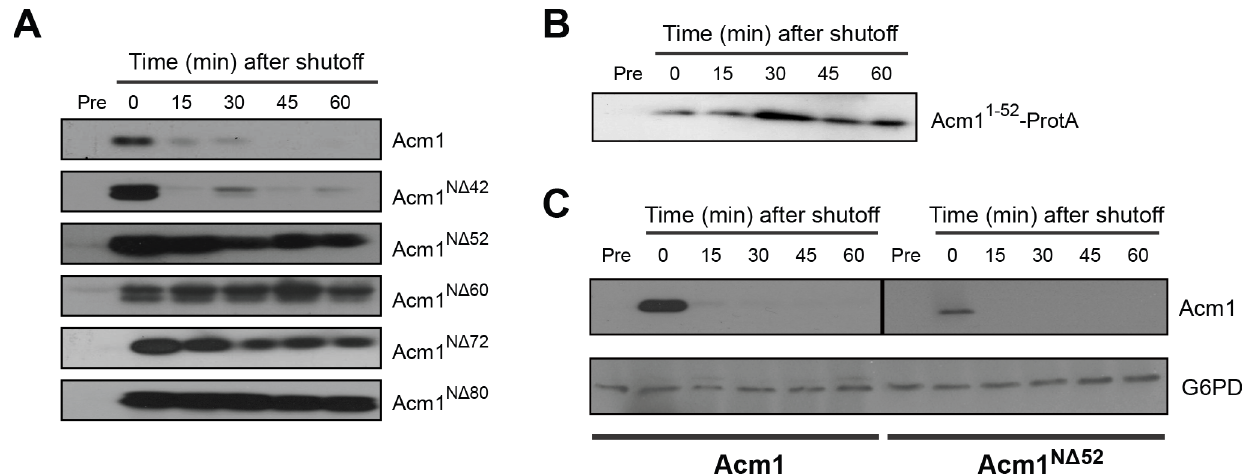
Figure 6. Proteolysis of an Acm1-ProtA fusion protein in G1 requires the N-terminal 52 amino acids of Acm1. A) YKA247 cells transformed with P GAL1 constructs expressing ACM1 , acm1 N D 42 , acm1 N D 52 , acm1 N D 60 , acm1 N D 72 or acm1 N D 80 fused to the ZZ domain of Protein A were arrested in G1 and protein stability assayed over time by immunoblotting with anti-Protein A antibody. B) The same assay as panel A with cells expressing Acm1 amino acids 1–52 fused to Protein A. C) The stability of Acm1 and Acm1 N D 52 without the Protein A fusion were compared using the same assay as in panel A, but with anti-Acm1 antibody for immunoblot detection. G6PD is a loading control. G6PD loading controls were performed for all blots in panels A and B as well (not shown).